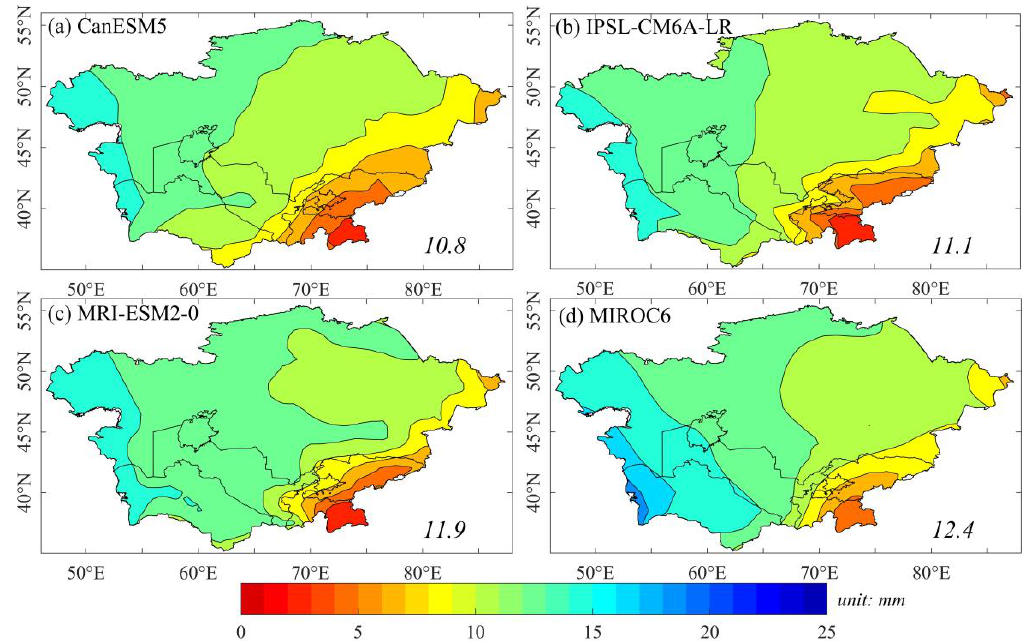
Figure 4. Spatial distribution of TCWV in Central Asia during the baseline period 1986–2005. The areal averaged TCWV for Central Asia is given at the bottom right of each panel (unit: mm).